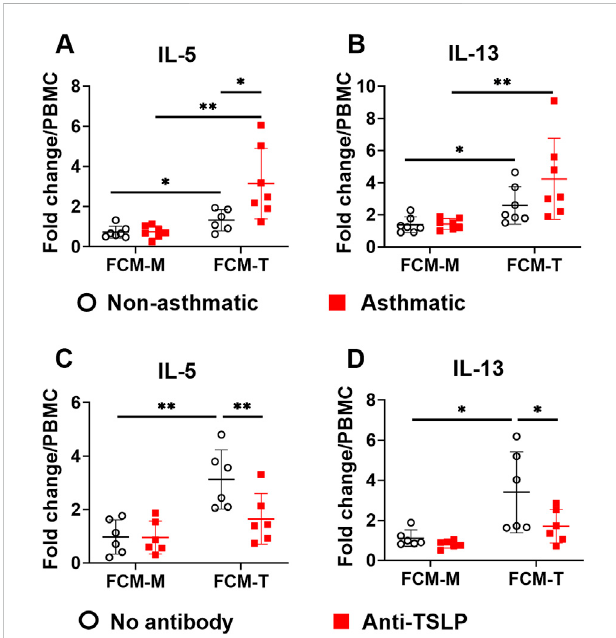
FIGURE 3 The effectsof fi broblastconditioned medium (FCM) onIL-5 andIL- 13 production by PBMCs. FCM was collected from either non-asthmatic or asthmatic lung fi broblasts that were cultured with medium (FCM-M) or TNF α (FCM-T) for 3 days. PBMCs were cultured with IL-33 (50 ng/ml) plus IL-2 (20 units/ml) with FCM-M or FCM-T for 4 days. IL-5 and IL-13 levels in the PBMC culture supernatants were measured by ELISA. Fold changes were quanti fi ed against the average value of PBMCs cultured with IL-33/IL-2 without FCM (A,B) . Anti-TSLP antibody (1 μ g/ ml) was added into the PBMC culture with FCM from asthmatic fi broblasts (C,D) . Fold changeswerequanti fi edagainst theaverage value of PBMCs cultured with IL-33/IL-2 without FCM. Data are shown as mean ± SD from N = 5 – 8 patient samples. Each dot represents one patient sample. * indicates signi fi cant difference p < 0.05. ** indicates signi fi cant difference p <